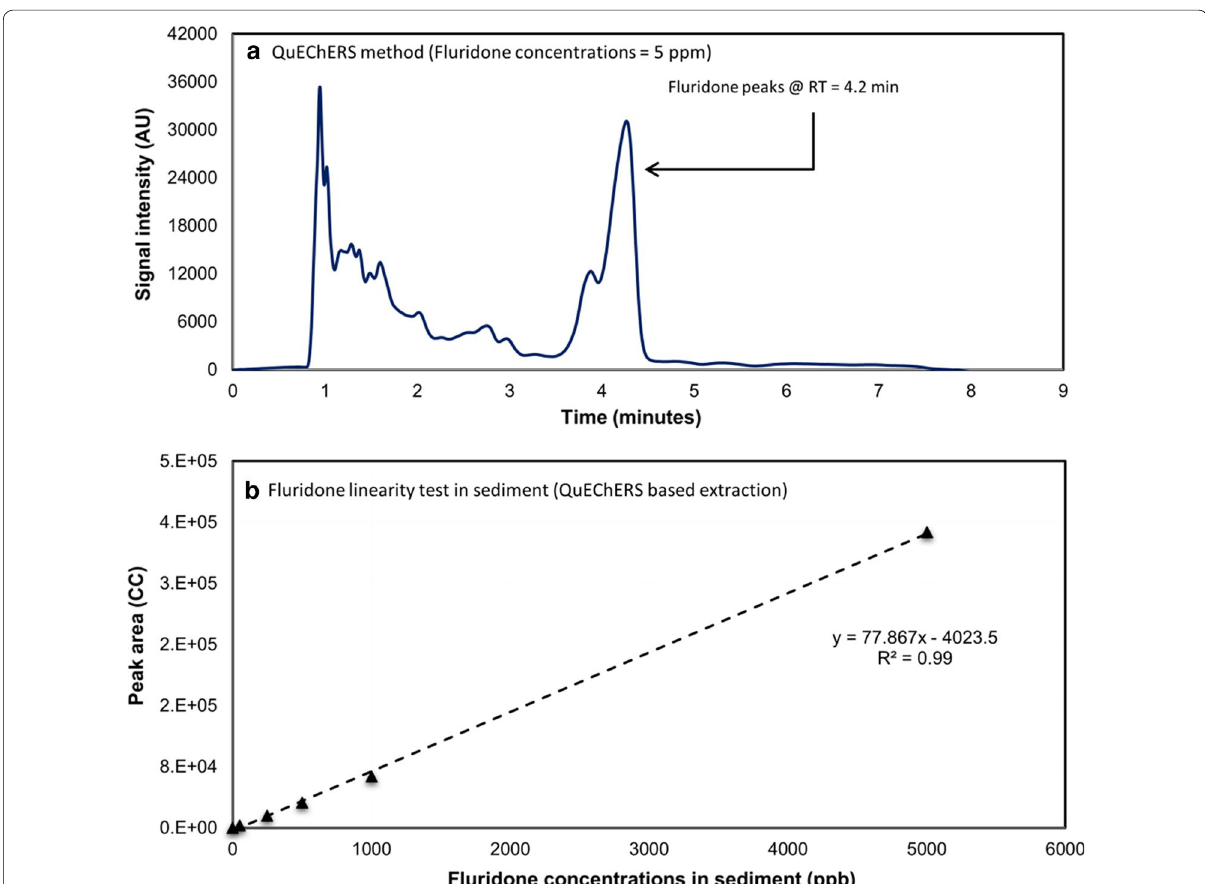
Fig. 3 Results of fluridone detection using QuEChERS (QM): a fluridone peak in sediment sample at 5 ppm; and b relationship between fluridone concentrations in sediment and peak